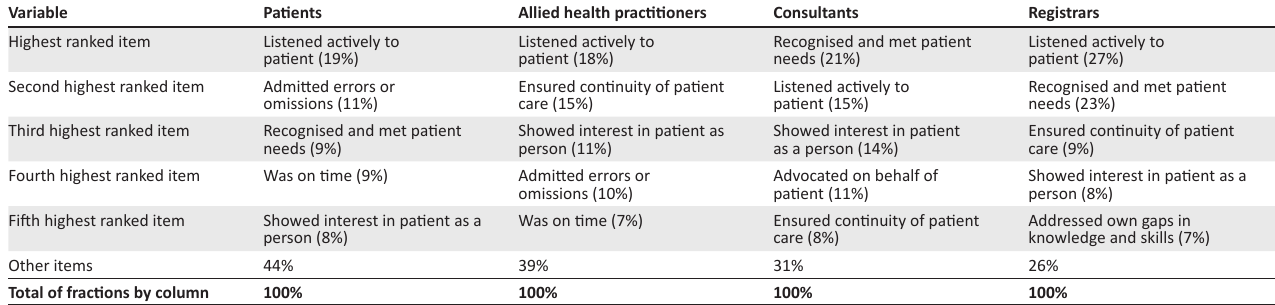
TABLE 3: Ranking of items by participants (with standardised scoring of rankings in %). Variable